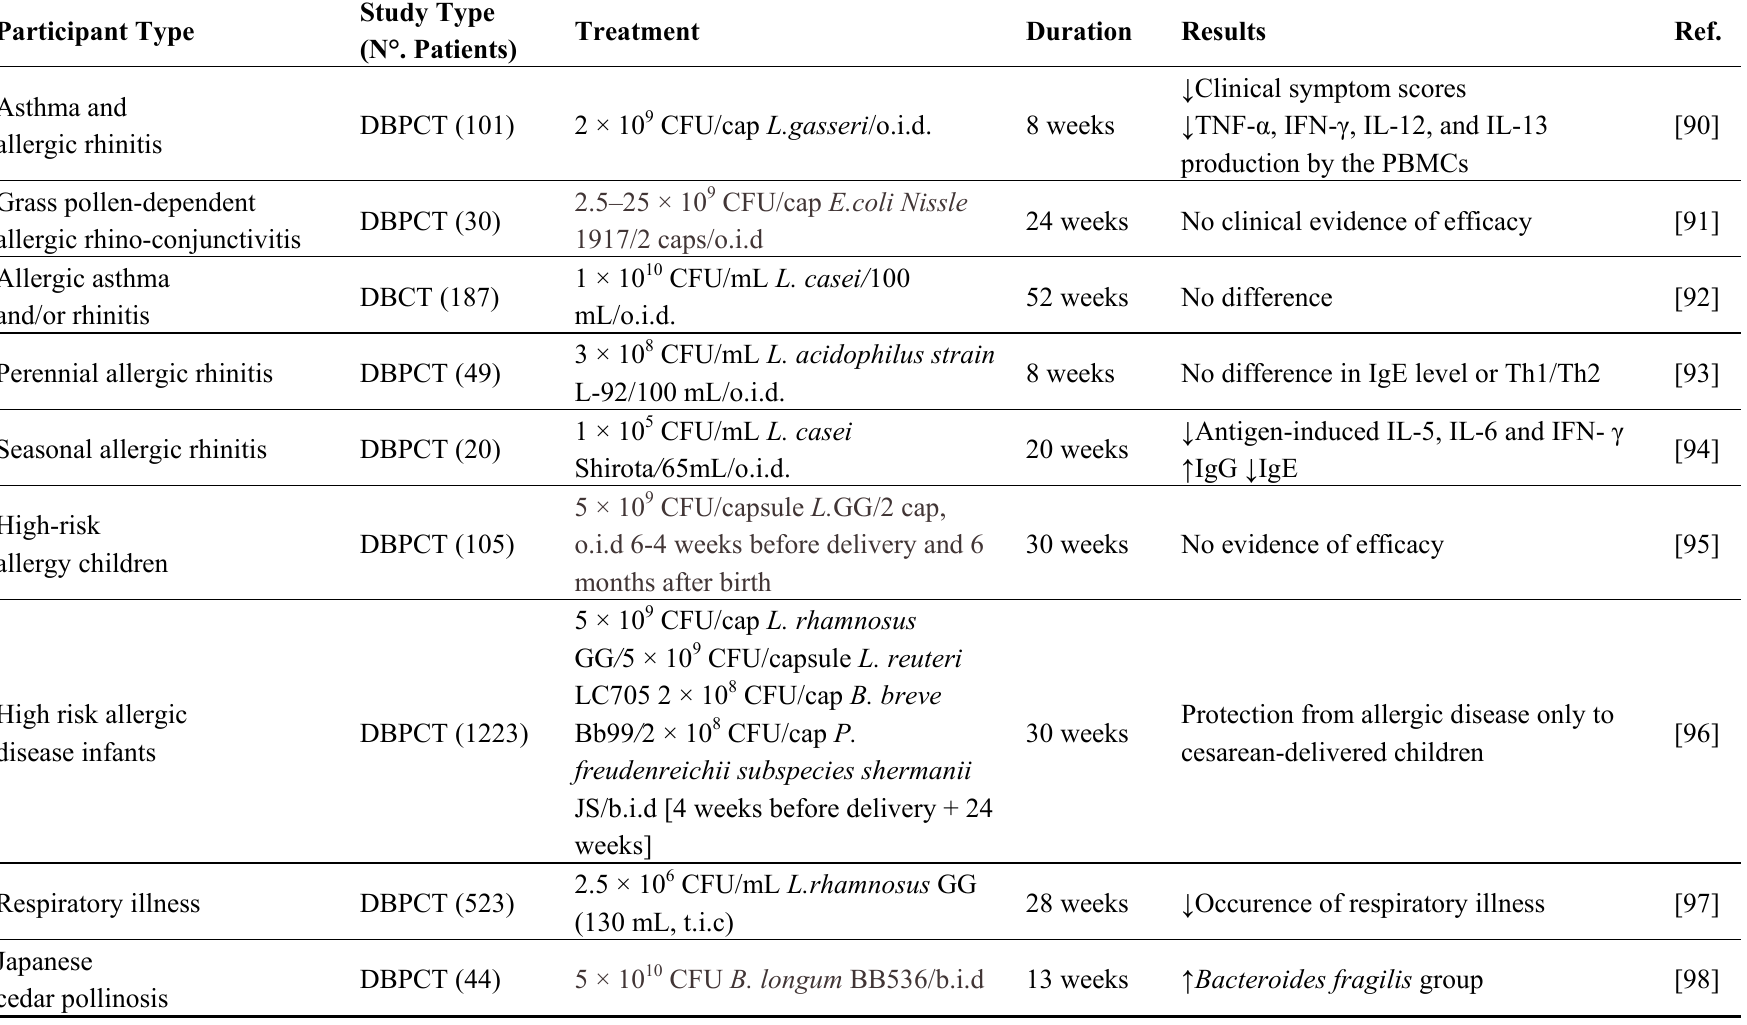
Table 7. Clinical studies of probiotics and respiratory allergic